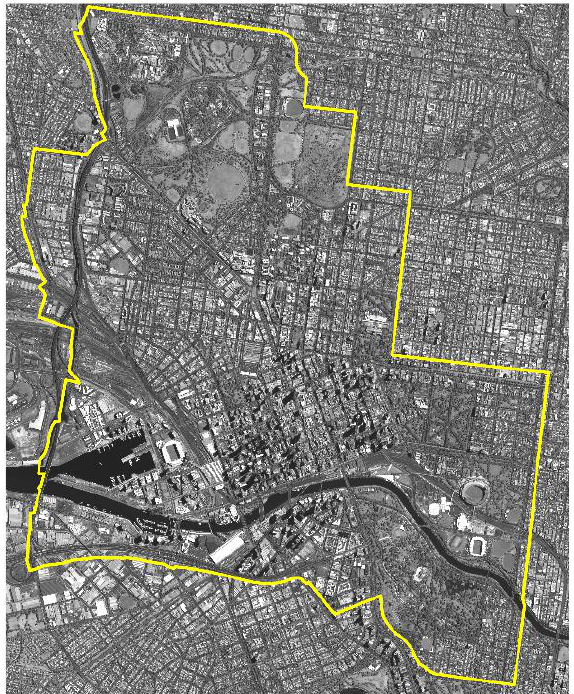
Figure 2. Pleiades-1A stereo imagery with the study area identified by the yellow boundary